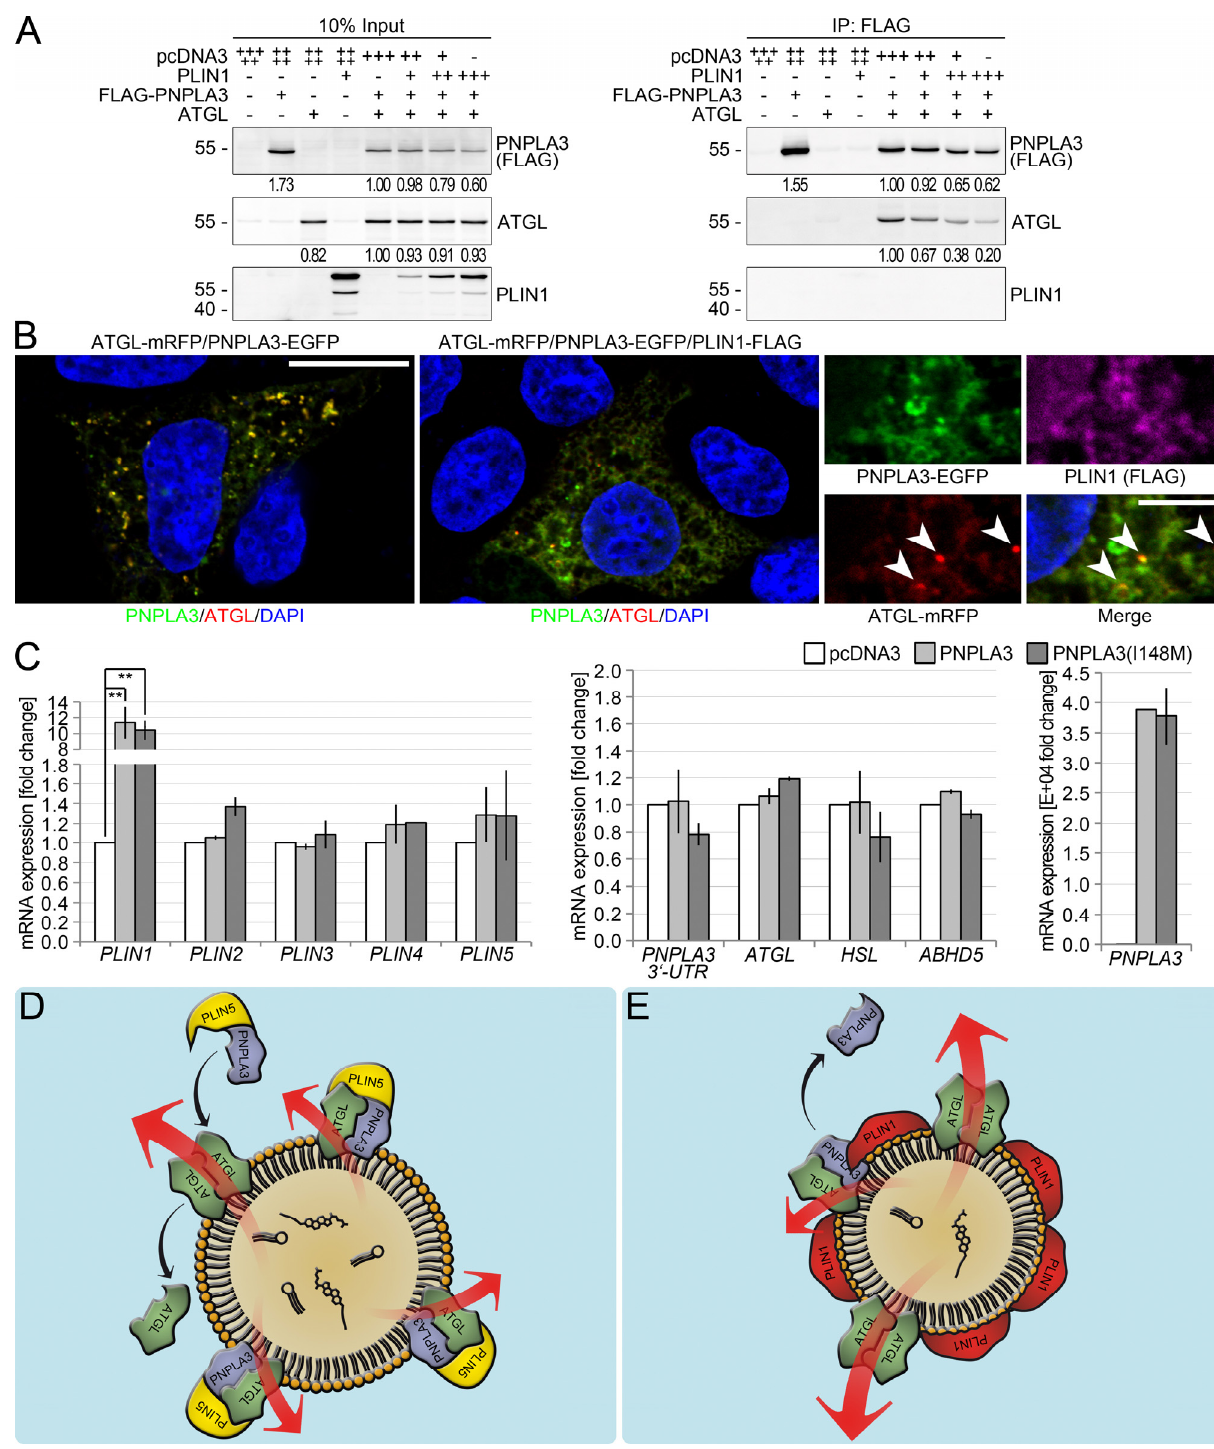
Figure 6. Regulatory effect of PNPLA3 and PLIN1. ( A ) Immunoblot analysis of PNPLA3, ATGL and perilipin 1 in co-immunoprecipitates of FLAG-tagged PNPLA3 in HEK293T-cells transfected with FLAG-tagged PNPLA3 and ATGL alone and together with increasing amounts of PLIN1. Although perilipin 1 does not interact with PNPLA3 or ATGL, its presence causes a disruption of the PNPLA3-ATGL-complex. ( B ) Immunofluorescence microscopy of ATGL with PNPLA3 alone or in the presence of perilipin 1 in HepG2-cells transfected with mRFP-tagged ATGL (red) and EGFP-tagged PNPLA3 (green) alone or together with FLAG-tagged PLIN1 (violet; nuclei: DAPI, blue). The presence of perilipin 1 induces translocation of PNPLA3 from LDs to the cytoplasm and reduces the number of ATGL-positive foci. Arrowheads indicate residual ATGL/PNPLA3-double positive foci.